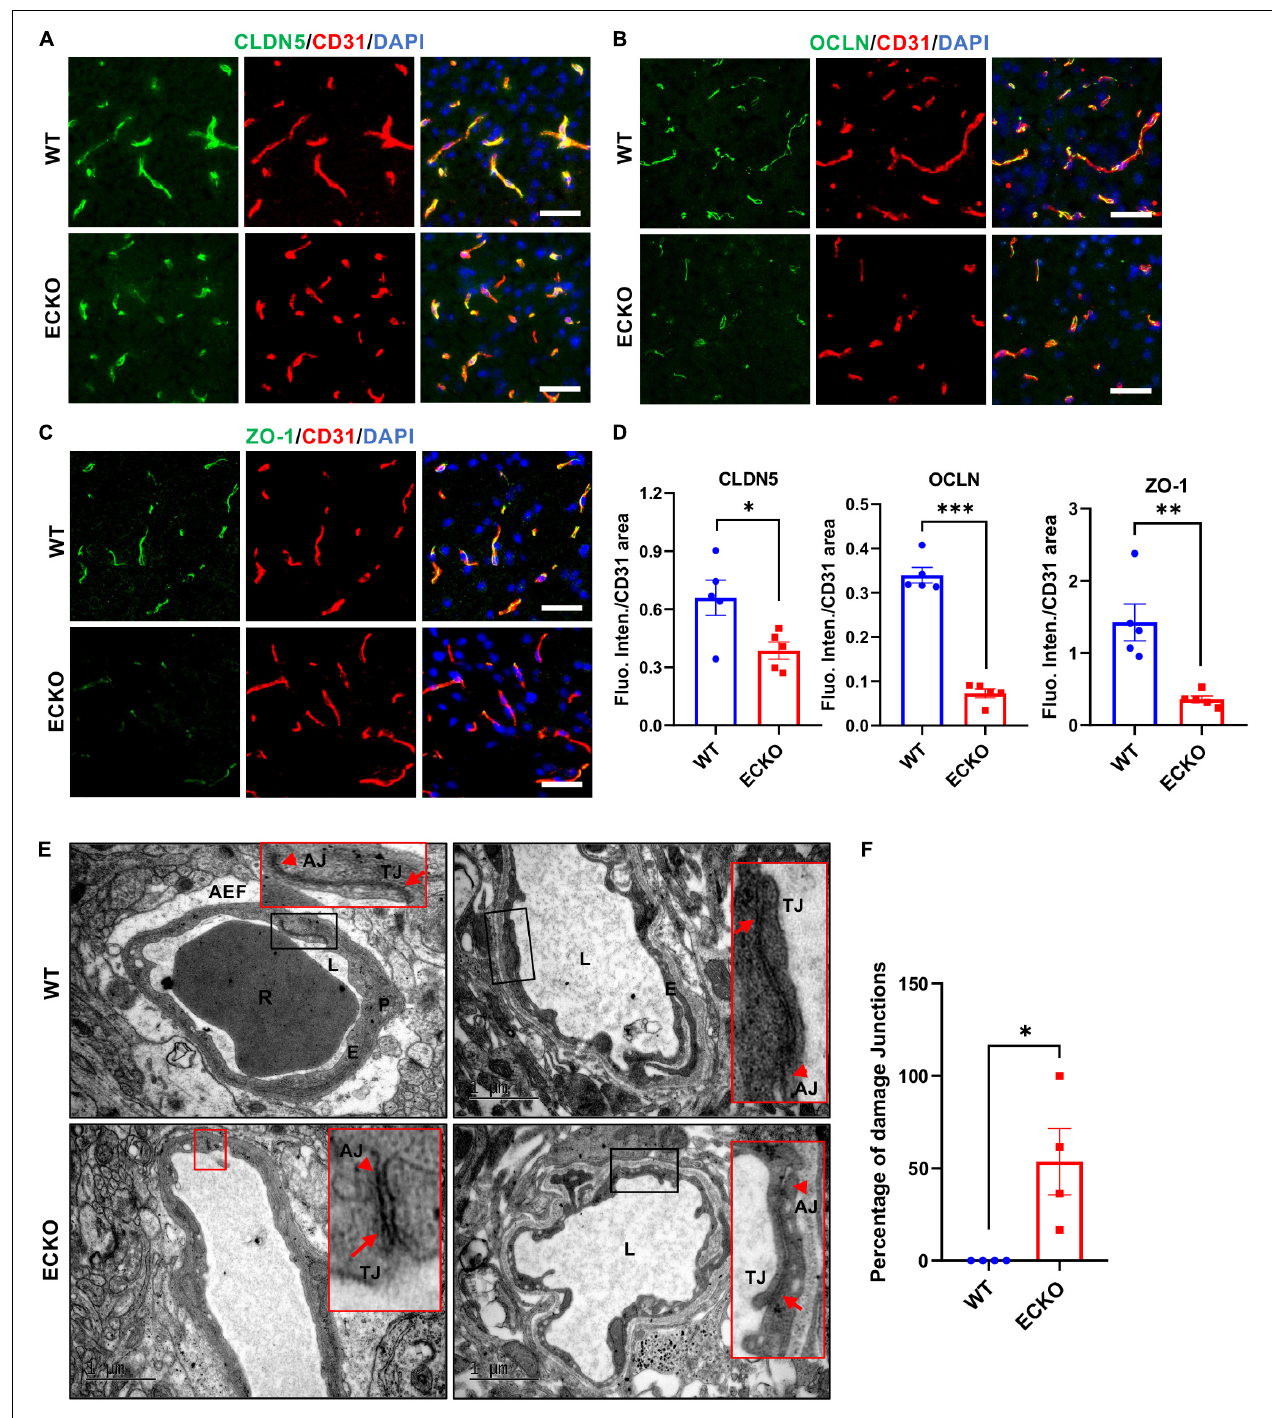
FIGURE 3 | Endothelial cell-specific deletion of β -catenin decreases TJ protein levels and disrupts the intercellular junction ultrastructure. (A–C) Immunofluorescence staining showing the expression levels of tight junction (TJ) proteins in the cerebral cortex of β -cat WT mice and β -cat ECKO mice, respectively. Scale bars: 100 µ m. (D) Quantifications of the fluorescence intensity of CLDN5, OCLN, and ZO-1 normalized with CD31 area, respectively. (E) Representative TEM images from β -cat WT control (upper panel) and β -cat ECKO mice (lower panel). Red boxed images are magnified versions of black-boxed images. Arrowheads indicate adherens junctions (AJs), and arrows indicate apical tight junctions (TJs) in both β -cat WT control and ECKO mice. Lower panel red boxed images show damaged AJs and TJs, while upper panel red boxed images show normal AJs and TJs. AEF, astrocyte end-feet; E, endothelial Cell; L, lumen; P, pericyte; R, red blood cells. Scale bars: 1 or 2 µ m. (F) Quantification of the percentage of damaged intercellular junctions in β -cat ECKO mice compared with β -cat WT control. Data are mean ± SD. n = 4 mice per group, at least five microvessels per mouse were examined. Significance of data is represented as: ∗ P < 0.05, ∗∗ P < 0.01, ∗∗∗ P < 0.001.